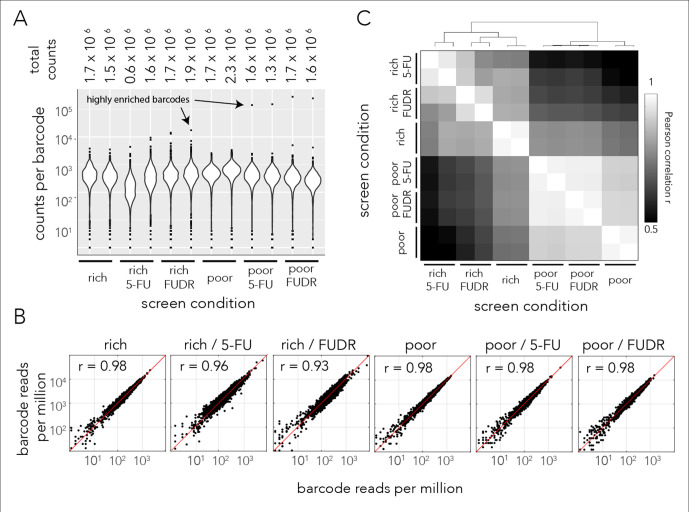
Sequencing statistics of pooled genetic screens.(A) Barcode coverage in individual screen after de-multiplexing reads that were sequenced on the same flow-cell. We identified roughly 1.5 million barcodes in each screen condition (top). Each individual barcode was identified on average 500 times (bottom). (B) A comparison of individual barcode frequency of biological duplicates revealed they are highly correlated. The Pearson r correlation is shown for each replicate pair. (C) The Pearson correlation coefficients between barcode counts from all screens' conditions. The correlation matrix reveals a hierarchical correlation structure: biological replicates are highly correlated, followed by high correlation by media type.